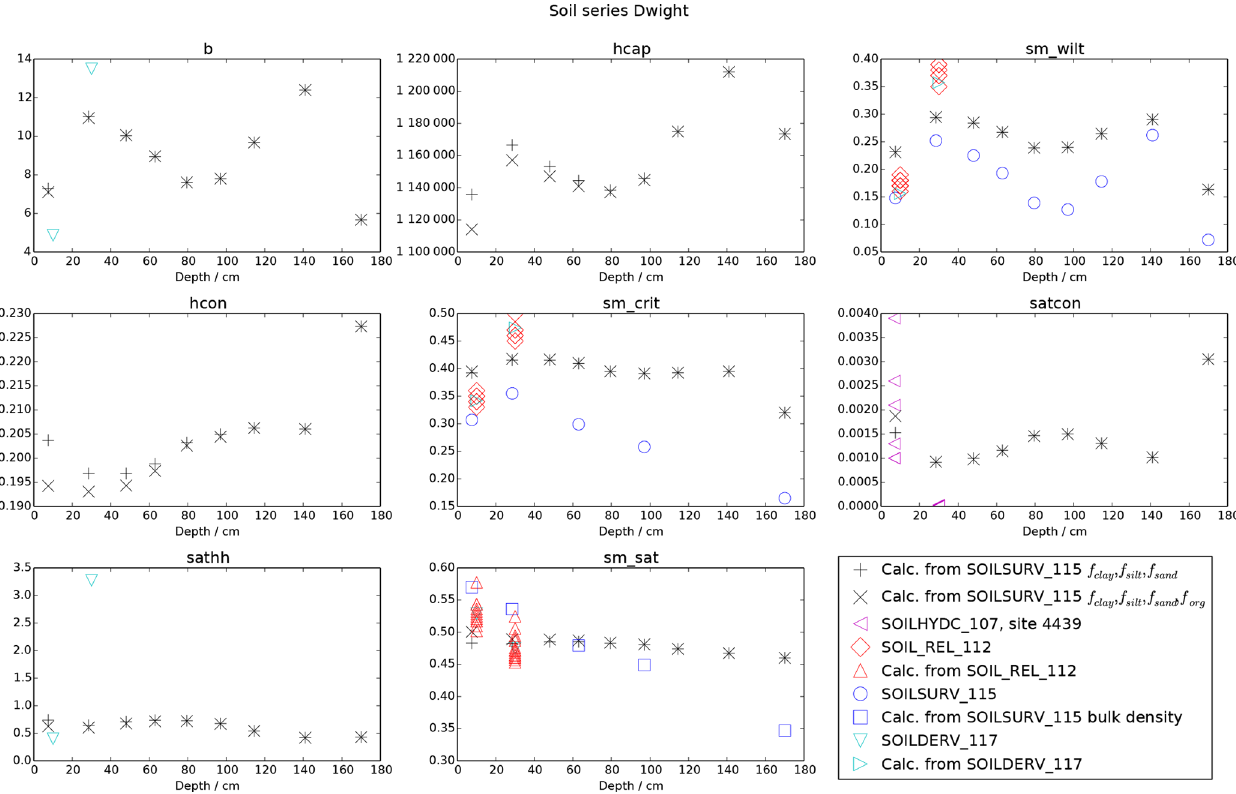
Figure A6. Soil ancillary variables needed by JULES, using the notation from the JULES namelists. When JULES is set to use soil hydraulic characteristics from Brooks and Corey (1964), these are b (exponent in soil hydraulic characteristics, i.e. b in Eq. A1), hcap (dry heat capacity in Jm − 3 K − 1 ), sm_wilt (volumetric soil moisture content at − 1 . 5MPa, θ wilt ), hcon (dry thermal conductivity in Wm − 1 K − 1 ), sm_crit (volumetric soil moisture content at − 1 / 30MPa, θ crit ), satcon (hydraulic conductivity at saturation in kgm − 2 s − 1 ), sathh (absolute value of the soil matric suction at saturation (cid:57) S in m) and sm_sat (volumetric soil moisture content at saturation θ S